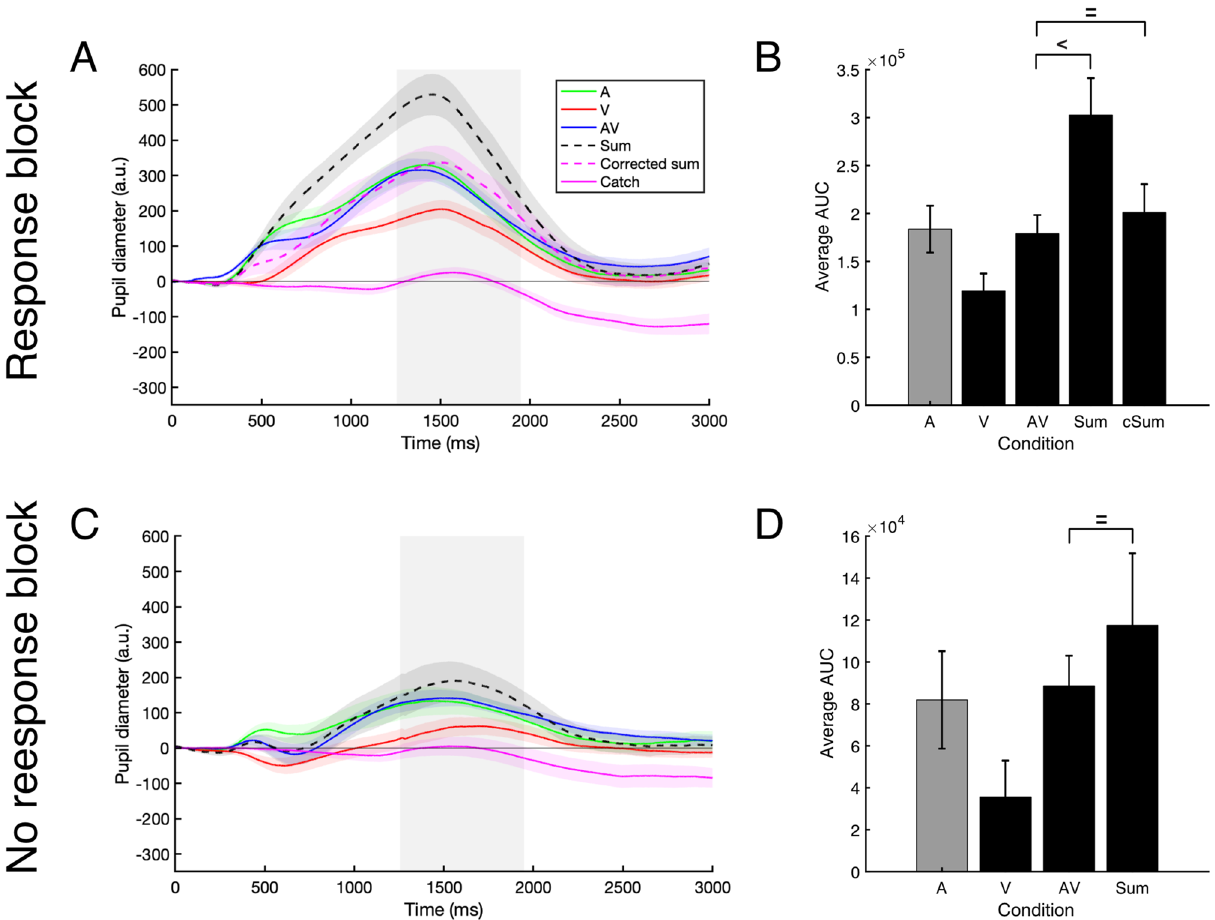
Figure 5. The average pupil traces and average area under the curve for the selected time window (grey area) for auditory (green), visual (red), audiovisual (blue) targets, and the (corrected) sum of auditory and visual pupil responses (purple and black dashed line) in the response (panel A and B ) and no response block (panel C and D ), and for catch trials (purple). Shaded areas around the pupil traces in panels A and C and error bars in panels B and D indicate standard error of the mean. The “equals” sign indicates BF 01 > 1.6, the “less than” sign indicates BF 10 >